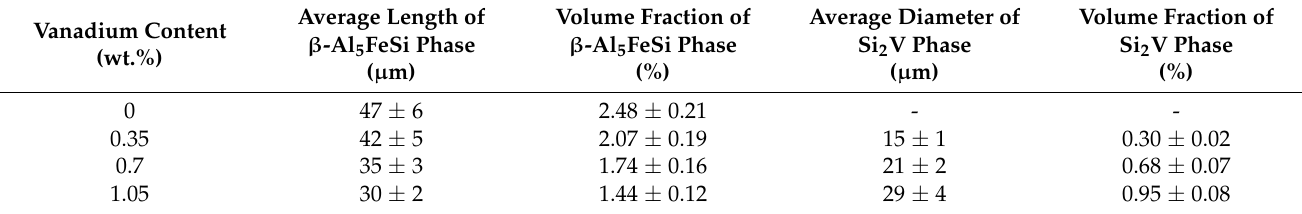
Table 3. Average size and volume fraction of compounds in the alloys with different vanadium contents. Vanadium Content